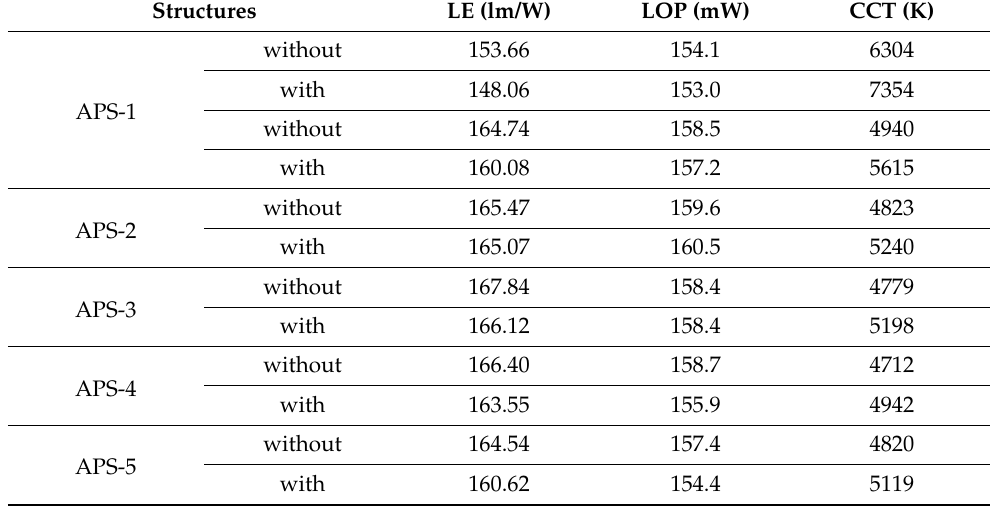
Table 1. LEs, LOPs, and CCTs of white LEDs with and without different APSs at the current of 100